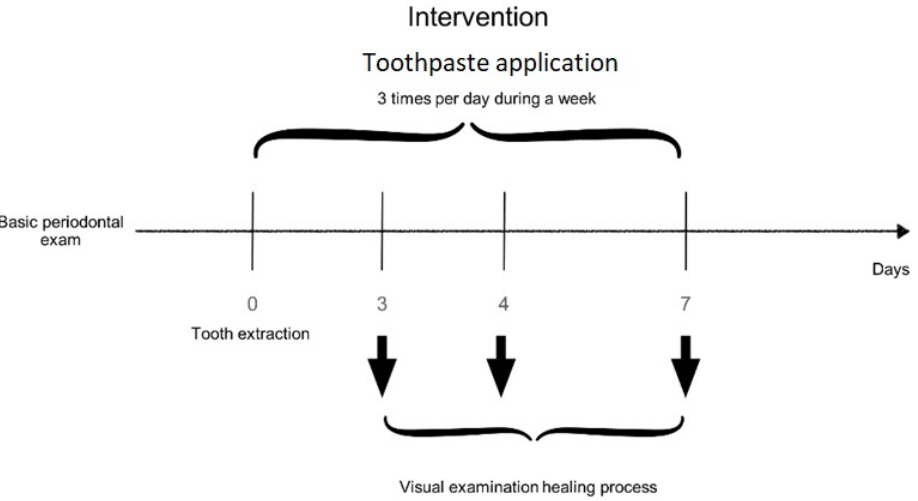
Figure 4. Study design. Visit protocol on healing process. The registered participants were 60 chronic periodontitis patients who had two or more teeth with high dental mobility, and they would need to have the extraction performed. Patients received test or control paste depending on randomization and were instructed to use it three times a day for one week on the dental socket after